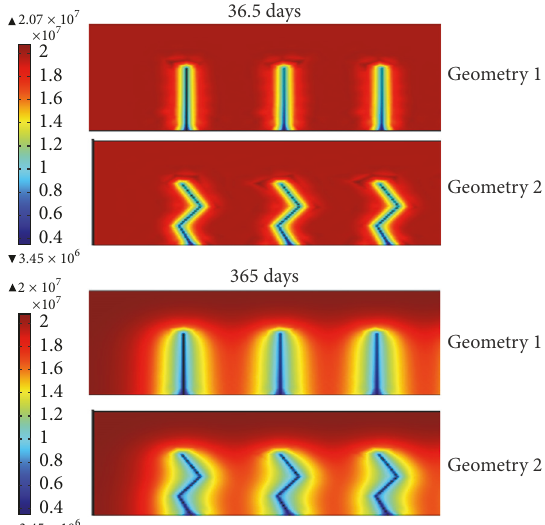
Figure 10: Effect of fracture geometry on gas pressure at the early and late production periods.